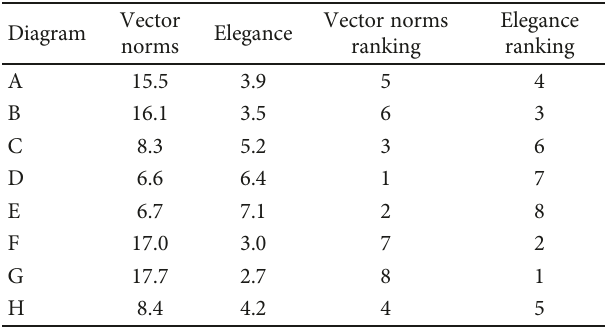
Table 9: Data for Spearman correlation coe ffi cient calculation.